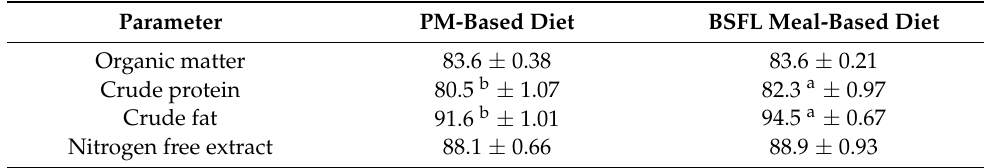
a,b Means in a row with different superscripts differ significantly ( p <